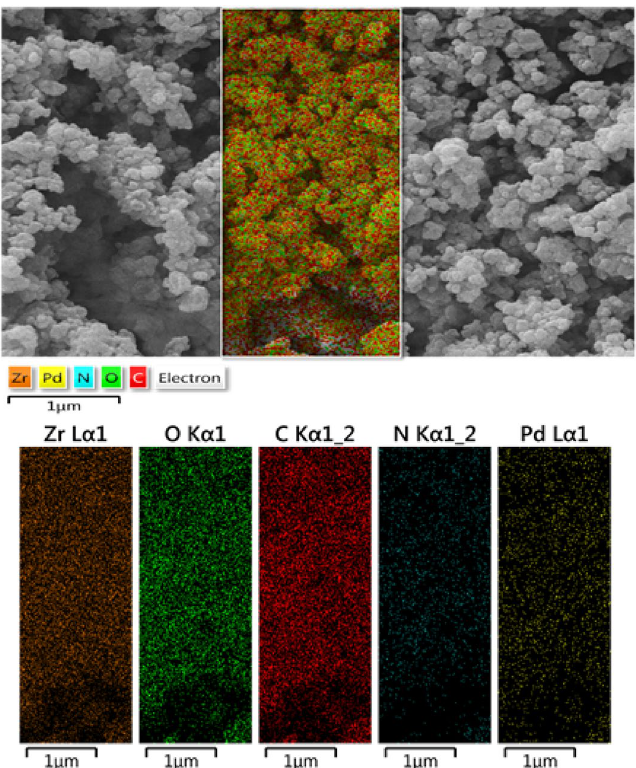
Figure 5. Elemental mapping of nanocomposite UiO-66-biguanidine/Pd with the atomic distribution of Zr, O, C, N, and